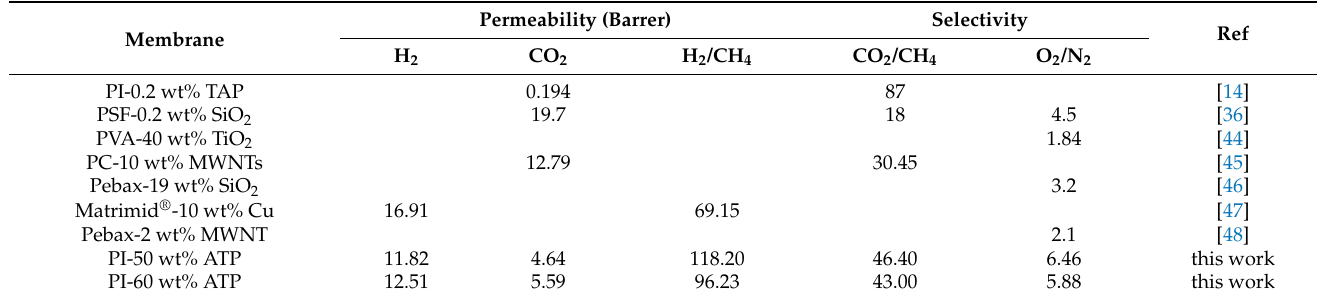
Table 2. Gas separation property comparison between some membranes reported in literatures and this study.